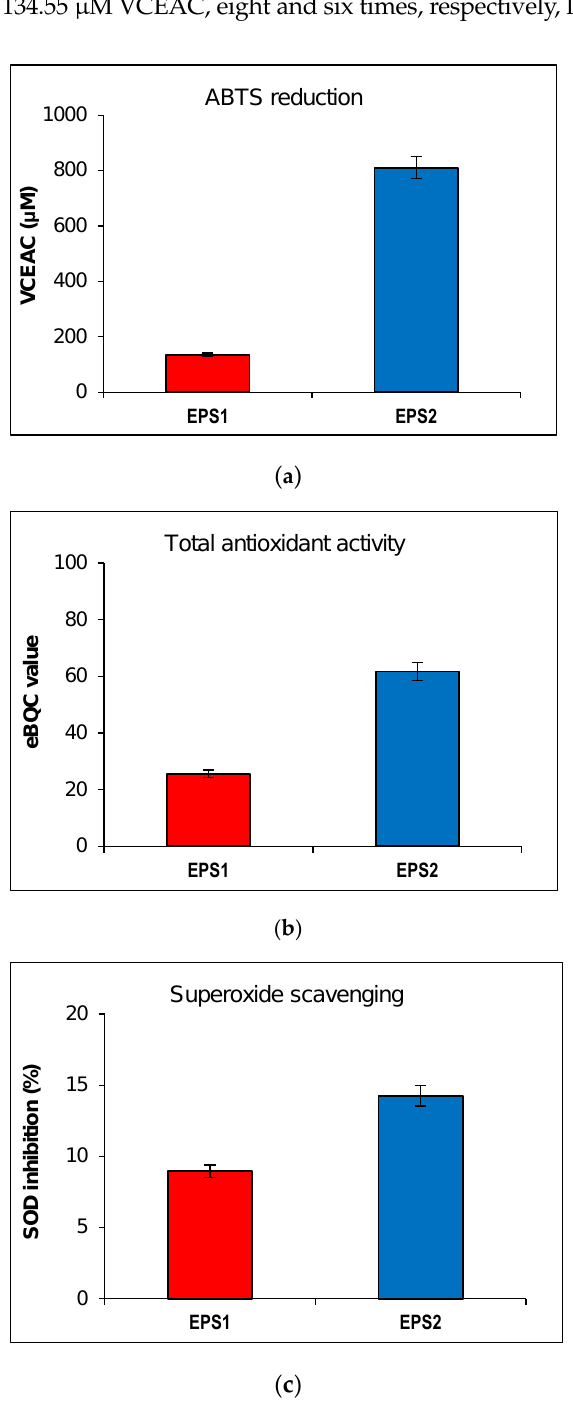
Figure 5. Antioxidant activity of EPS1 and EPS2 from B. licheniformis 24. ( a ) ABTS reduction measured in VCEAC ( μ M); ( b ) total antioxidant activity in eBQC values; ( c ) superoxide scavenging measured in % SOD activity inhibition. All measurements were performed in triplicates.